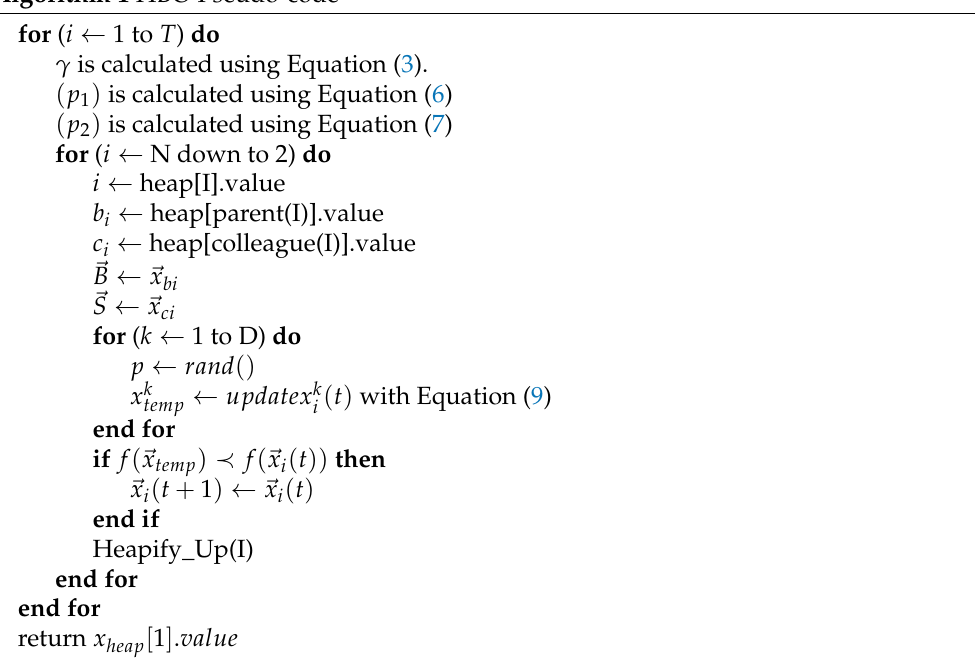
Algorithm 1 HBO